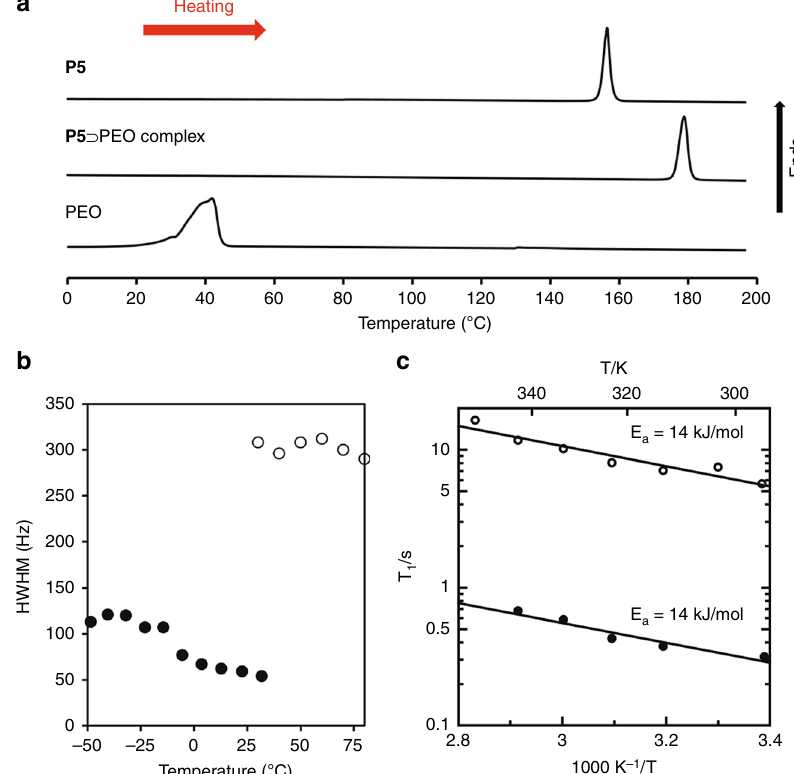
Fig. 5 Thermal transitions and molecular dynamics of PEO con fi ned in 1D pillar[5]arene channels. a DSC heating curves of P5 , P5 ⊃ PEO, and PEO. PEO1000-OH was used. b Plots of the half-width at half-maximum (HWHM) values of the signal from complexed and un-complexed PEO (Fig. 2b) at different temperatures (open circles = P5 ⊃ PEO complex and fi lled circles = neat PEO). c Arrhenius plot of 13 C T 1 as a function of temperature (open circles = P5 ⊃ PEO complex and fi lled circles = neat